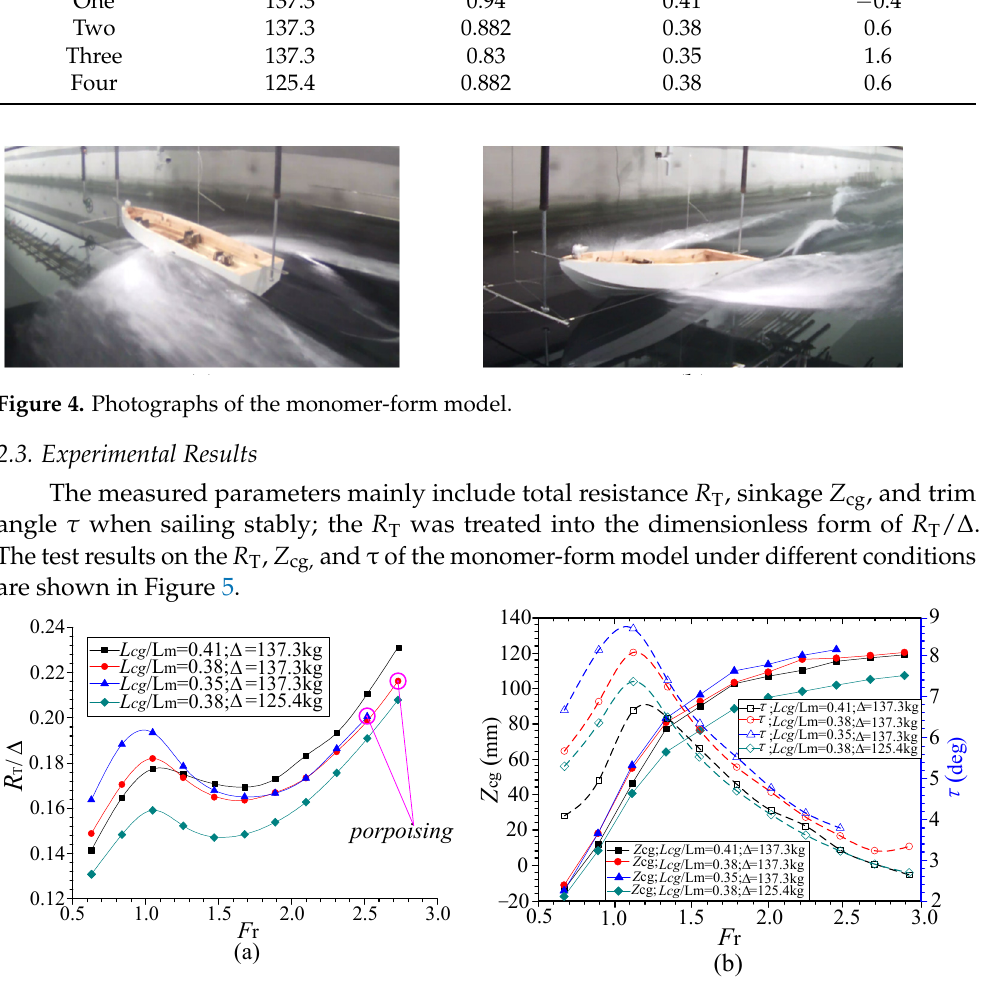
Figure 5. Test results of the monomer-form model: ( a ) total resistance; ( b ) sinkage and trim angle.